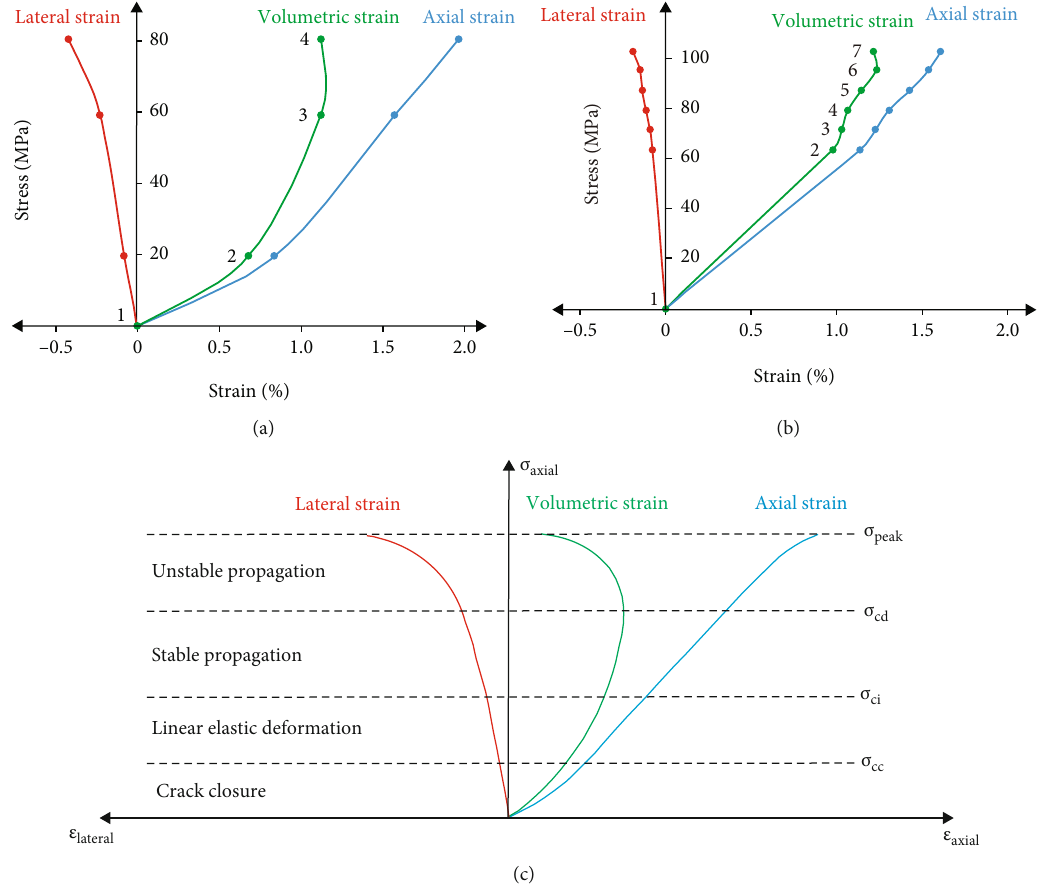
Figure 7: Uniaxial compression stress-strain curves of S3 (a), S4 (b), and Eberhardt et al. [40]